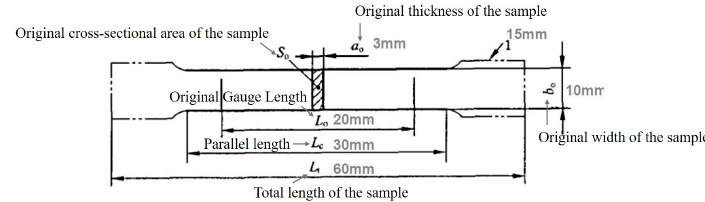
Figure 2. Tensile specimen geometry.